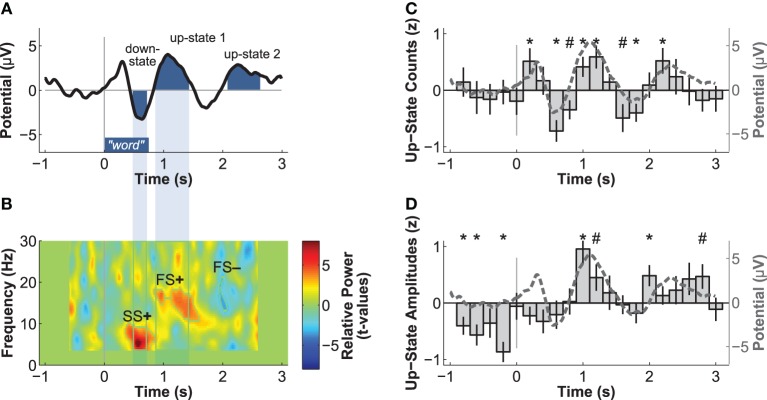
Electric brain responses at electrode Fz to word presentation during sleep. Event-related potentials (A) and event-related spectral power changes (B) to word-presentation during sleep. Temporal overlaps of the down-state with the increase in slow-spindle power (SS+) and of the up-state 1 with the increase in fast-spindle power (FS+) are highlighted. Normalized count (C) and peak-amplitudes (D) of discrete slow-oscillation up-states identified before and after word presentation. Both the number and the amplitudes of up-states are increased during the time windows of the ERPs identified as up-states 1 and 2, which indicates that these ERPs reflect up-states. *p < 0.05, #p < 0.10 (uncorrected p-values for two-tailed t-tests).